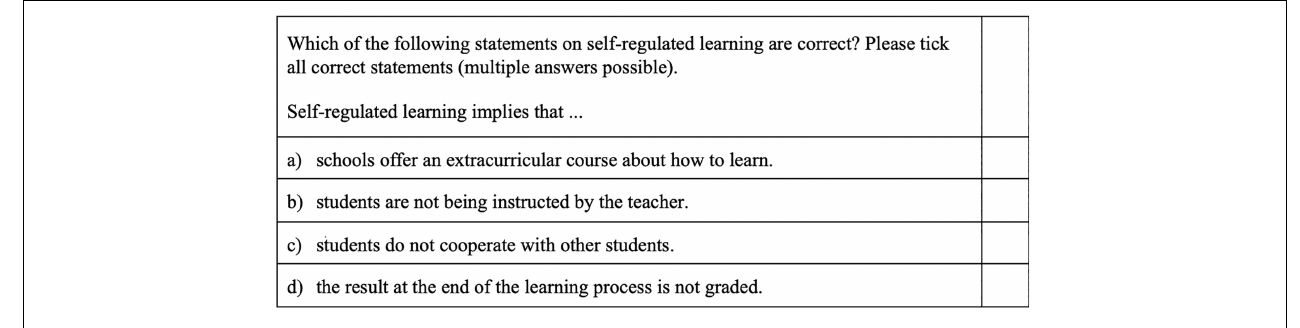
FIGURE 2 | Sample item of the CK-SRL test.